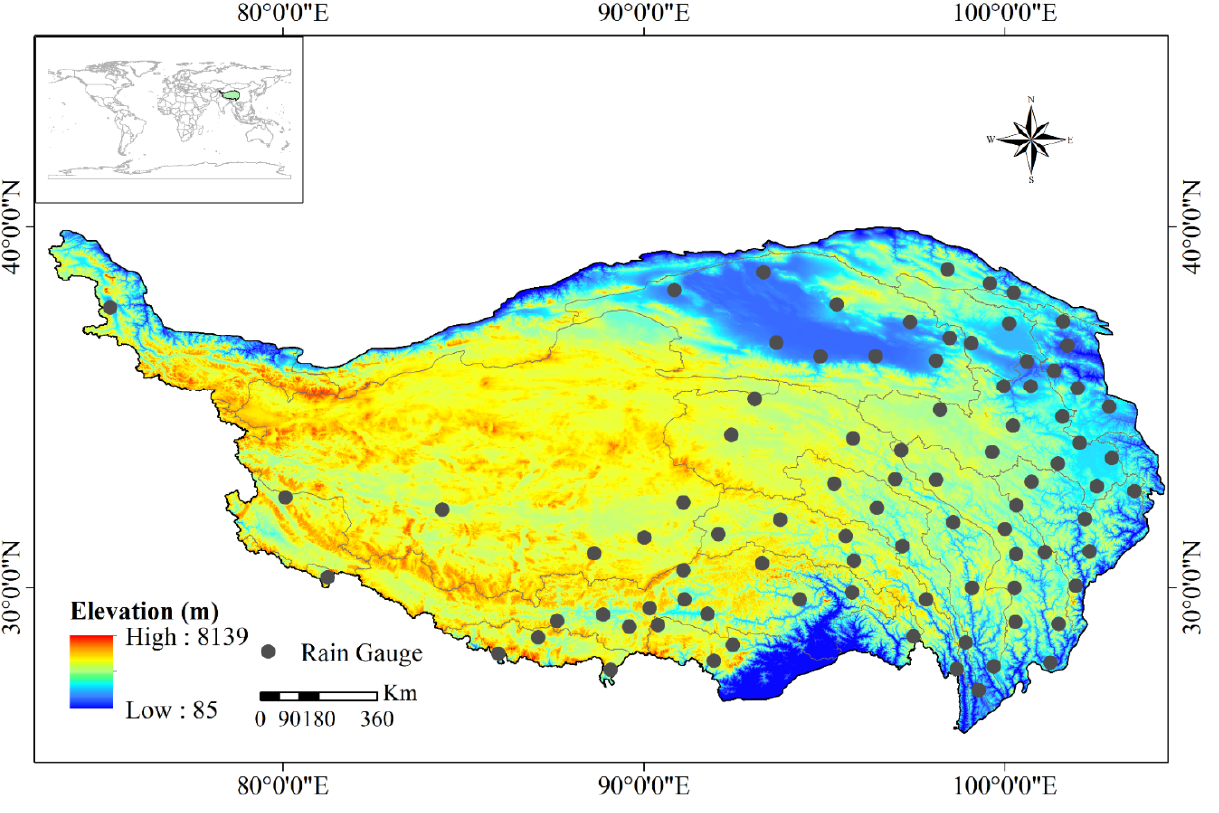
Figure 1. Location of the Tibetan Plateau and spatial distribution of rain gauges.